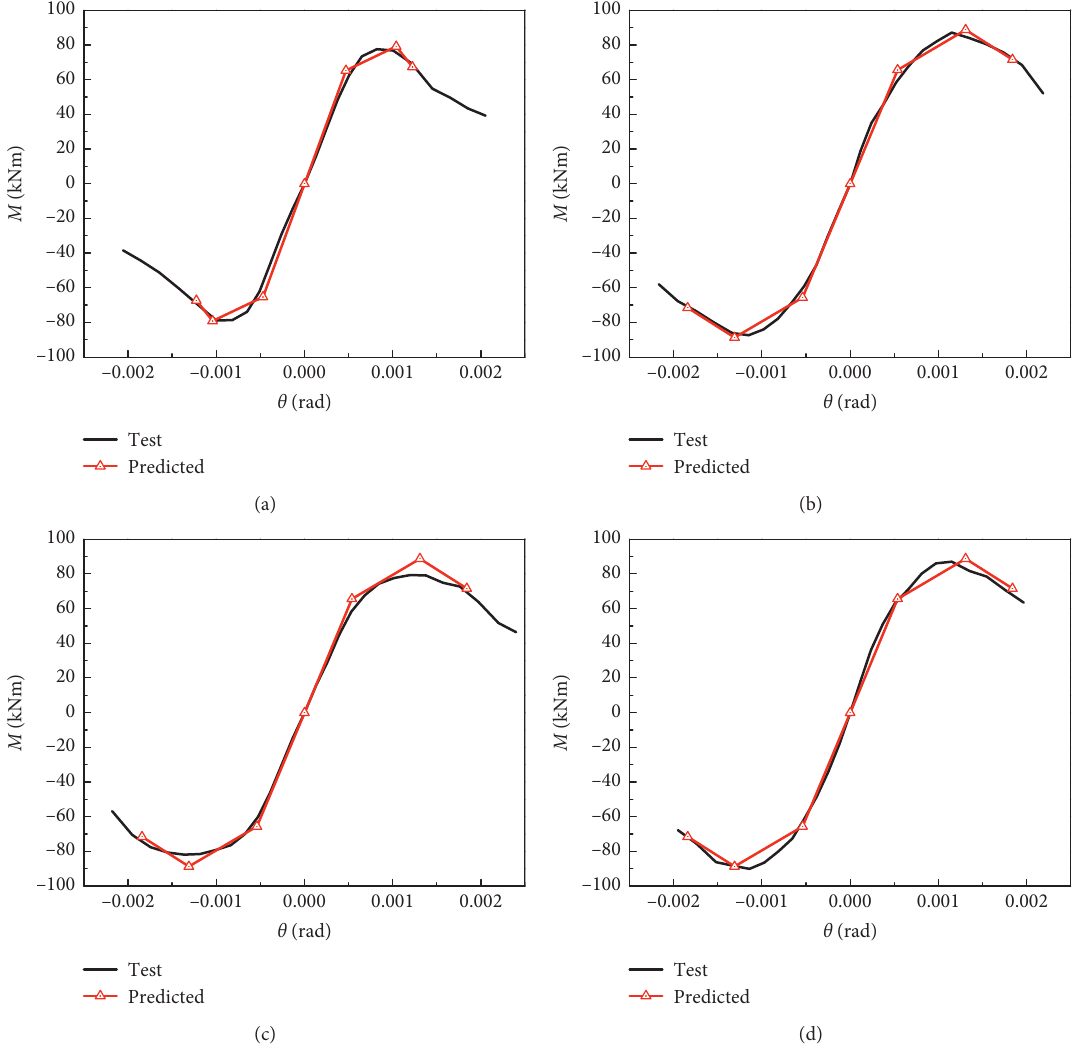
Figure 18: Comparison between the experimental and the predicated skeleton curves for (a) J -6-1, (b) J -8-1, (c) J -8-2, and (d) J -8-3. Table 11: Comparison of the ductility from the experimental and the simplified skeleton curves. Specimen J -6-1 J -8-1 J -8-2 J -8-3 Ductility of the test 2.95 3.20 3.01 3.04 Ductility of the simplified skeleton curve 2.76